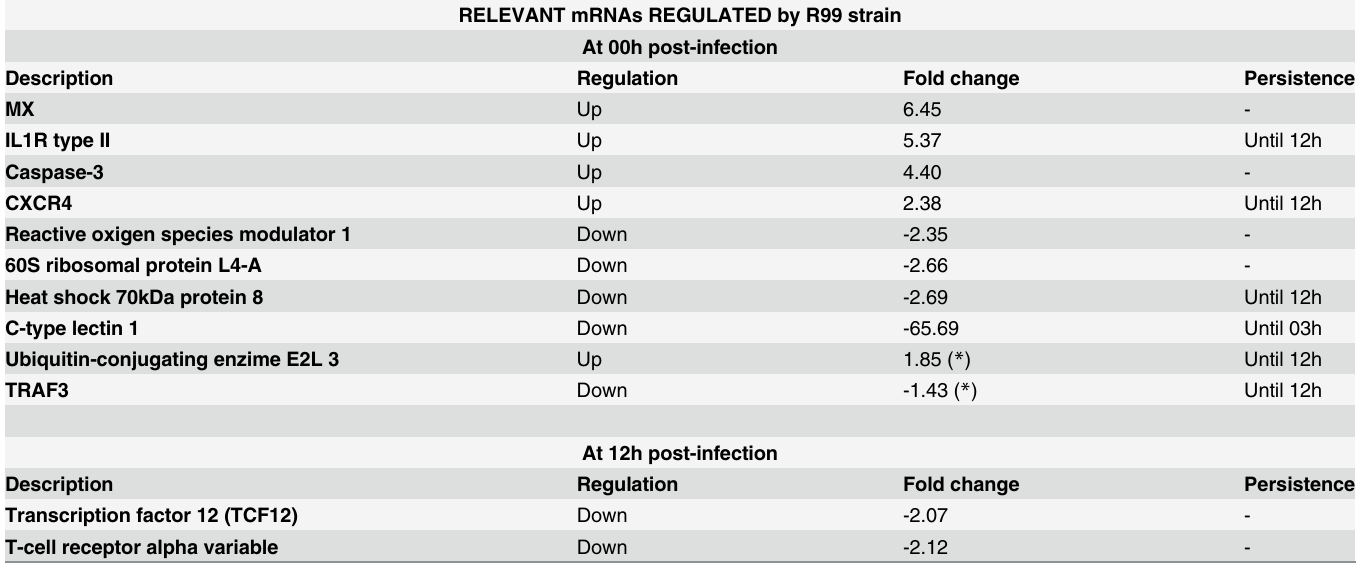
Table 3. List of relevant immune-related transcripts regulated during V . vulnificus R99 infection by loop analysis. Asterisk ( * ) represents relevant mRNAs with FC < 2, however with statistically significant difference (p < 0.05). RELEVANT mRNAs REGULATED by R99 strain